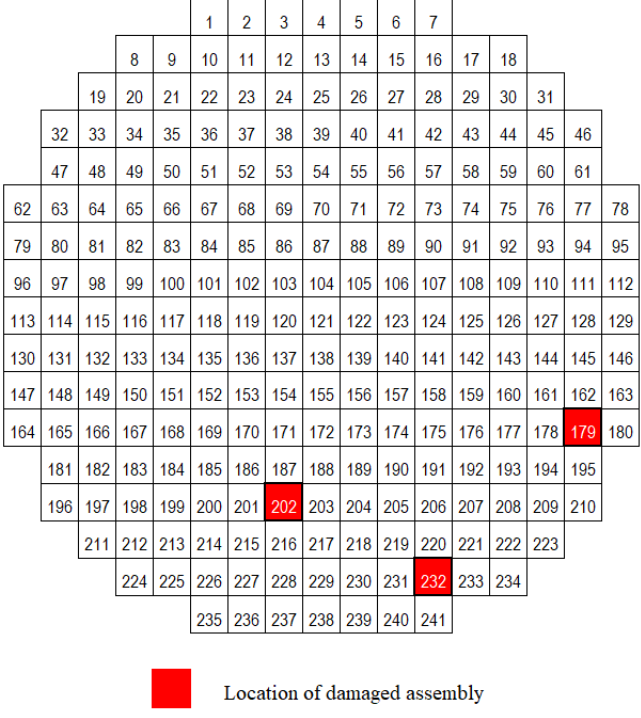
Figure 11. Location of damaged fuel assembly.